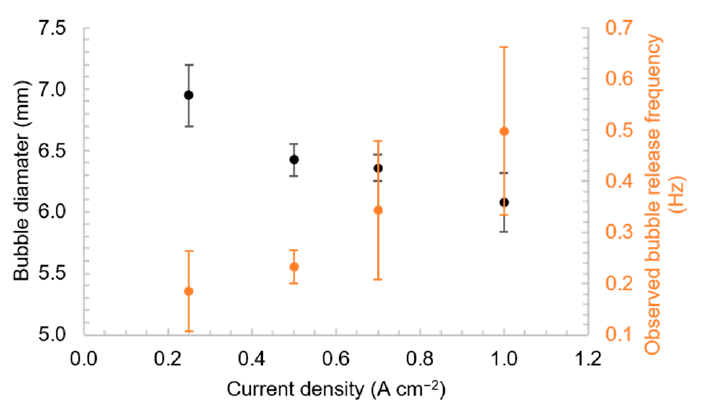
Figure 11. Bubble diameter after detachment from the horizontal surface and bubble release frequency as a function of the nominal current density.